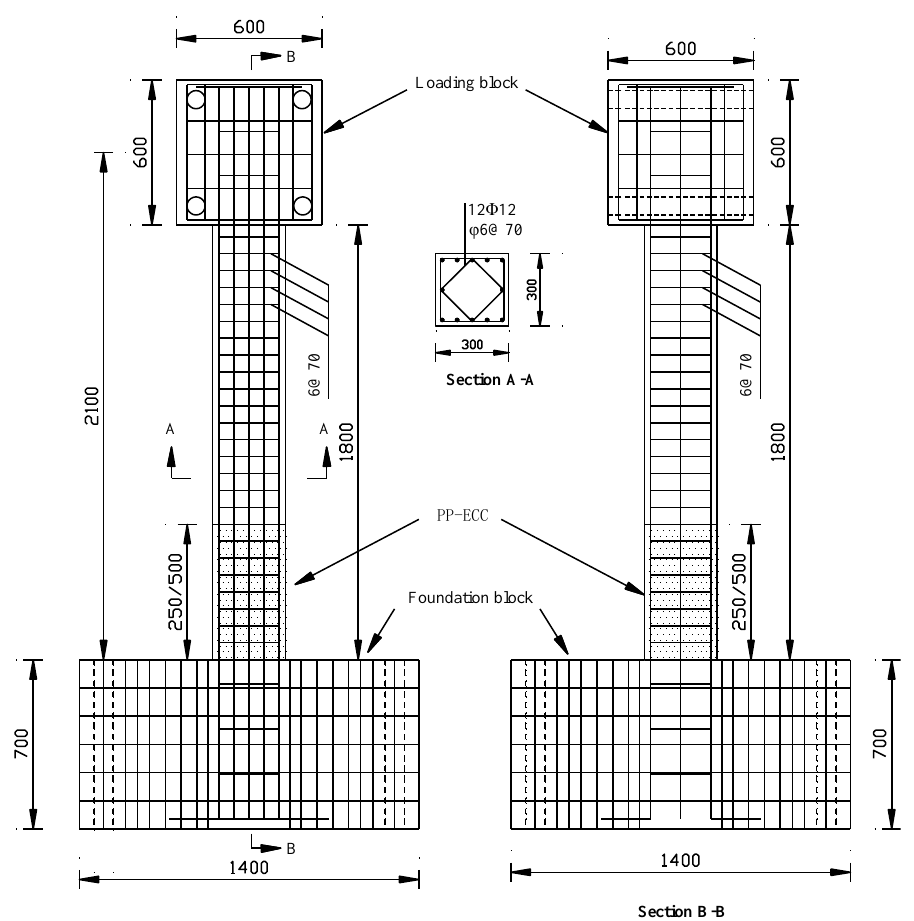
Figure 2. Geometry and reinforcing details of test piers (unit: mm). Table 3. Design parameters of specimens.